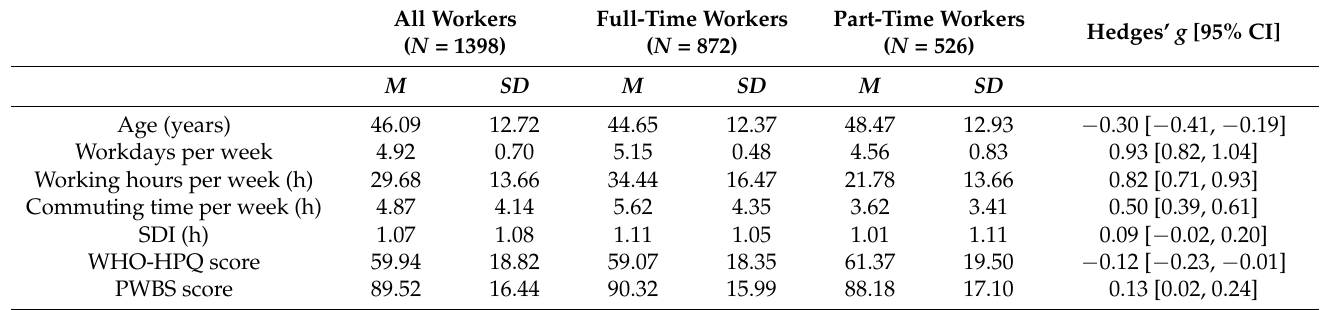
Table 2. Descriptive statistics and effect sizes.